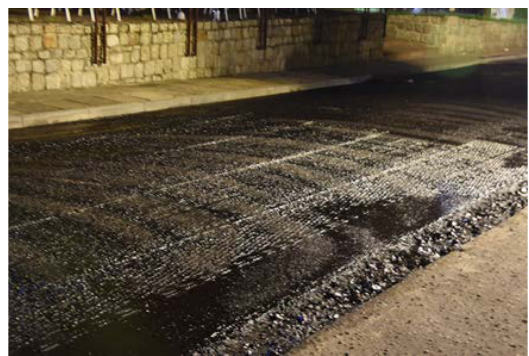
Figure 8. Compaction of the binder course AC 16W.